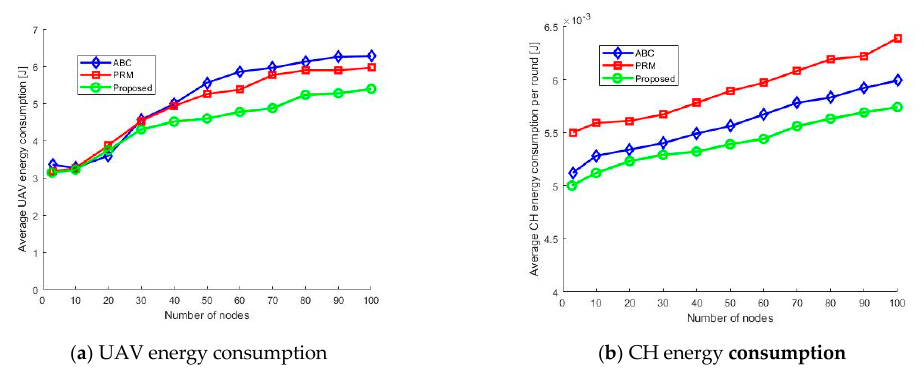
Figure 8. Energy